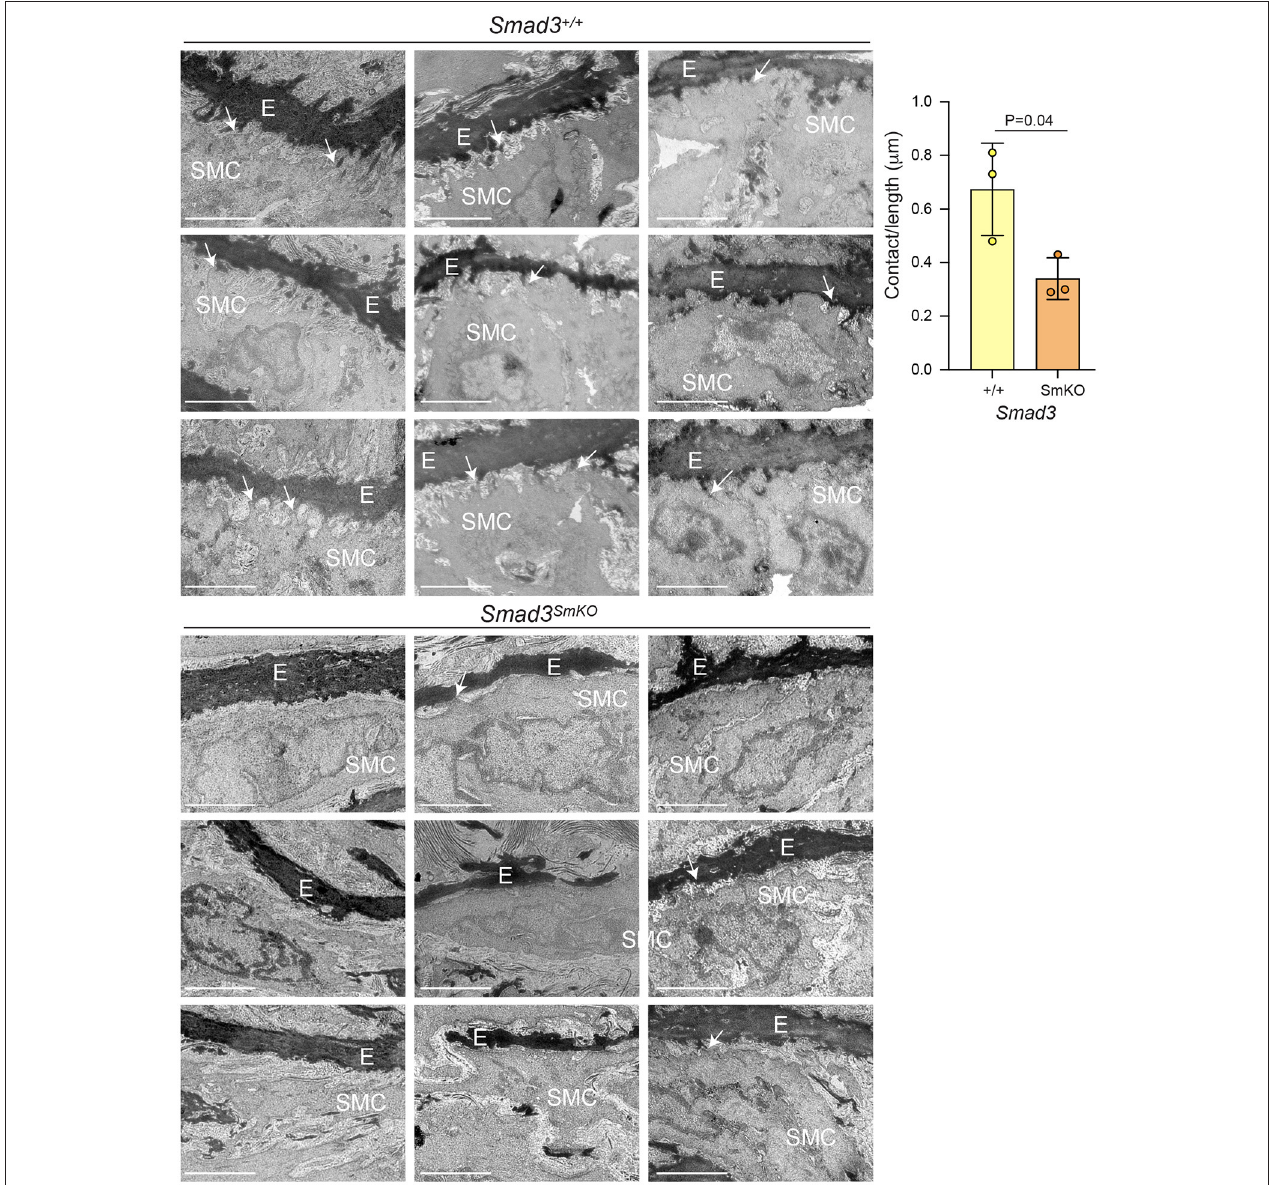
FIGURE 4 | Transcriptional alterations associate with loss of connections between VSMCs and the elastic lamellae in vivo . Representative electron micrographs of longitudinal sections of the aortic root of Smad3 + / + and Smad3 SmKO mice 10 weeks after Smad3 deletion (E, elastic lamellae; SMC, Smooth muscle cell, arrows indicate contact between SMCs and the ECM, note only some connections are labeled to help orient the reader to this feature). Three biological replicates, with three representative images from each animal, per condition are shown. Scale bar is 2 µ m. Cell protrusions < 50nm from elastin were counted manually by a blinded researcher. The total number of protrusions counted were normalized to the total measured elastic fiber’s length for each animal (Contact/length). P -value refers to two tailed Student’s t-test.